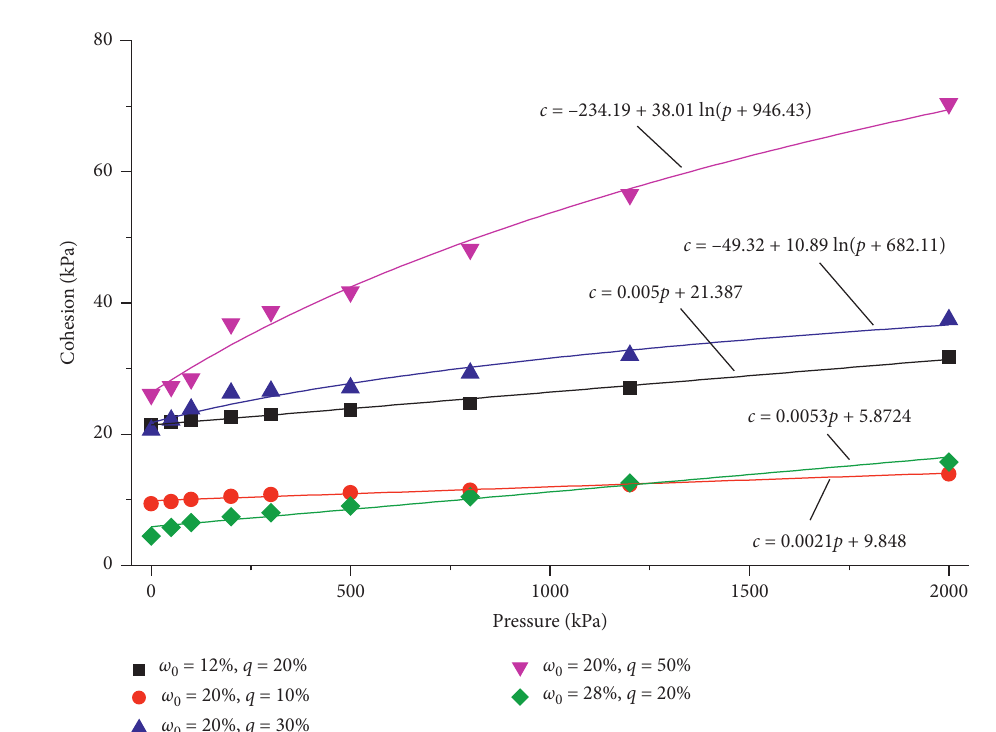
Figure 18: Fitting curves of cohesion and pressure.